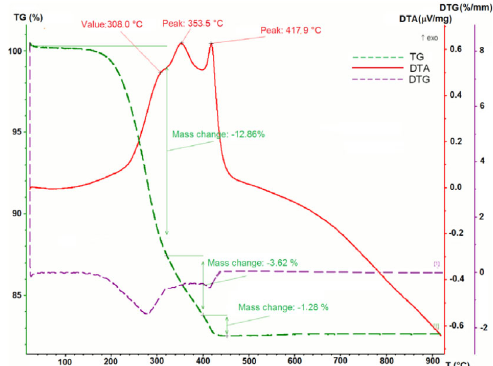
Fig. 1 Results of differential thermal analysis (DTA) and thermogravimetric analysis (TG and DTG) of a green varistor tape.